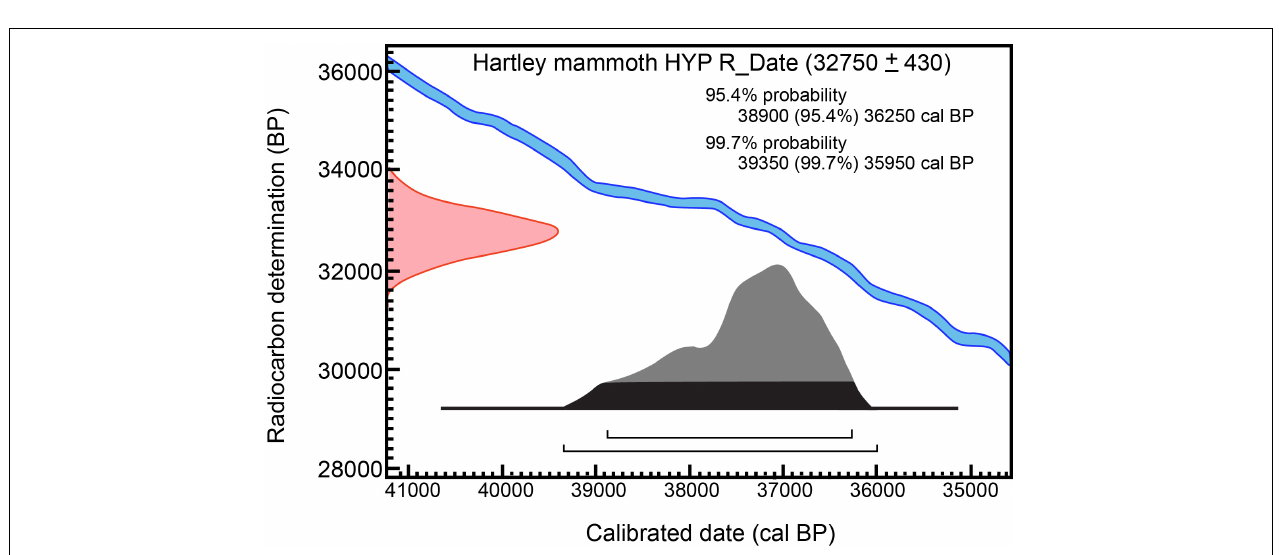
FIGURE 4 | AMS 14 C measurements on different Hartley mammoth bone collagen chemical fractions.